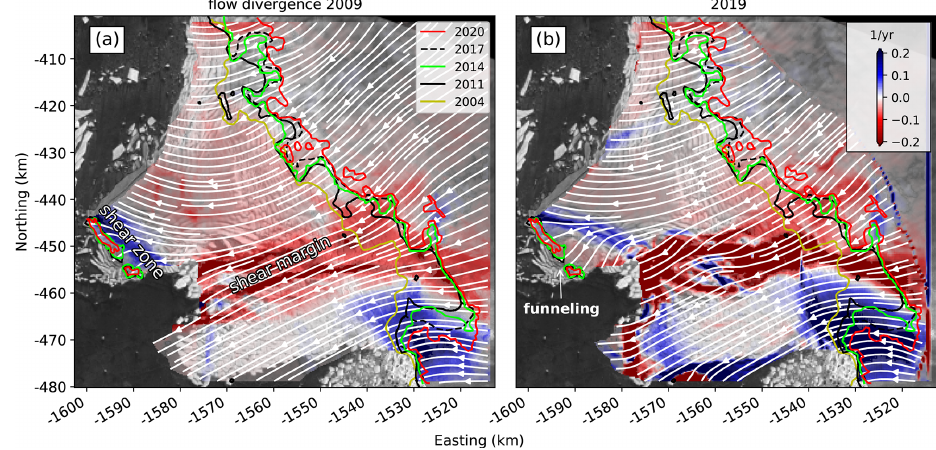
Figure 4. Ice flow divergence from (a) MEaSUREs data in 2009 and (b) Landsat-8 feature tracking in 2019 overlain on a Sentinel 1 SAR image from October 2019. Blue colors denote flow divergence and red colors flow convergence. Note the upstream migration of the shear zone near the pinning point and the funneling of ice streamlines between the two remaining portions of the pinning